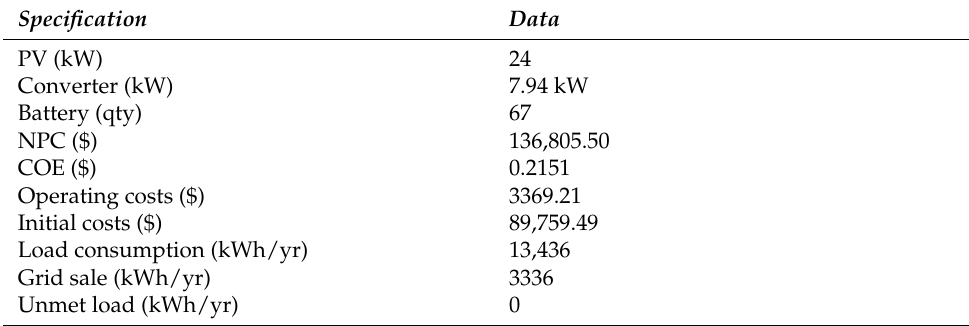
Figure 19. SOC of the BES for System 2 during an outage. As per the simulation result, most of the power provided by the PV system to the load during the daytime is shown in Figure 20.